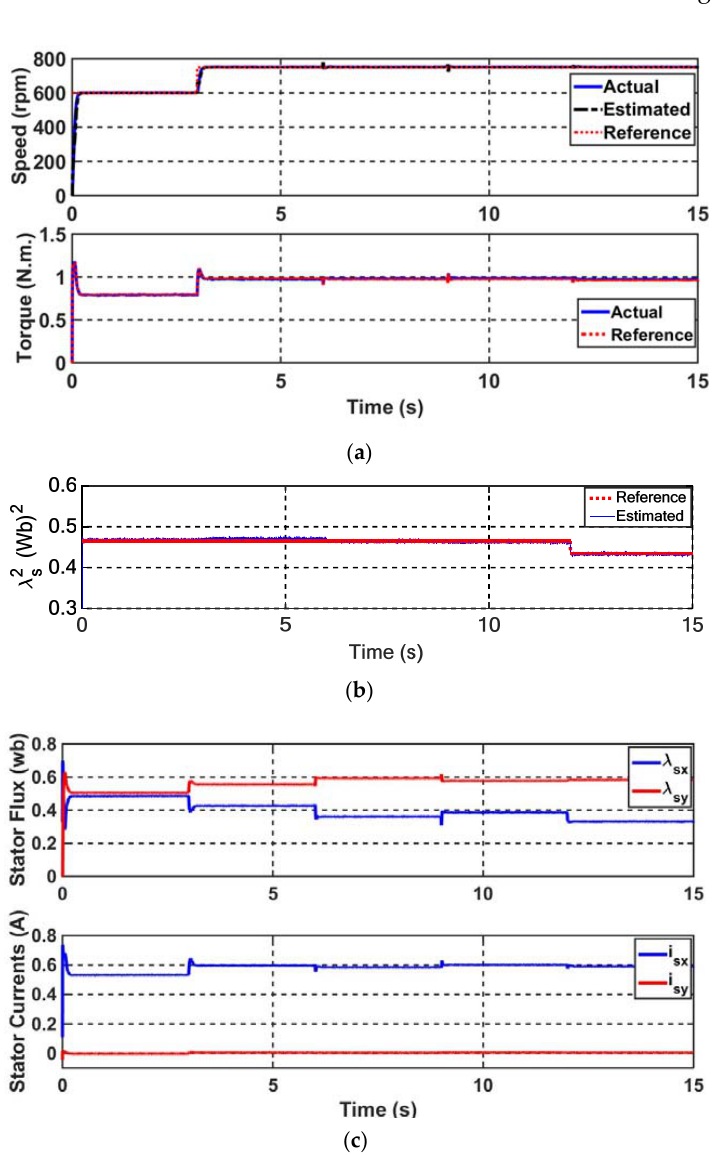
Figure 4. Simulation results of IPMSM drive: ( a ) torque and speed, ( b ) squared of stator flux, ( c ) X - and Y -axis components of stator fluxes and currents.